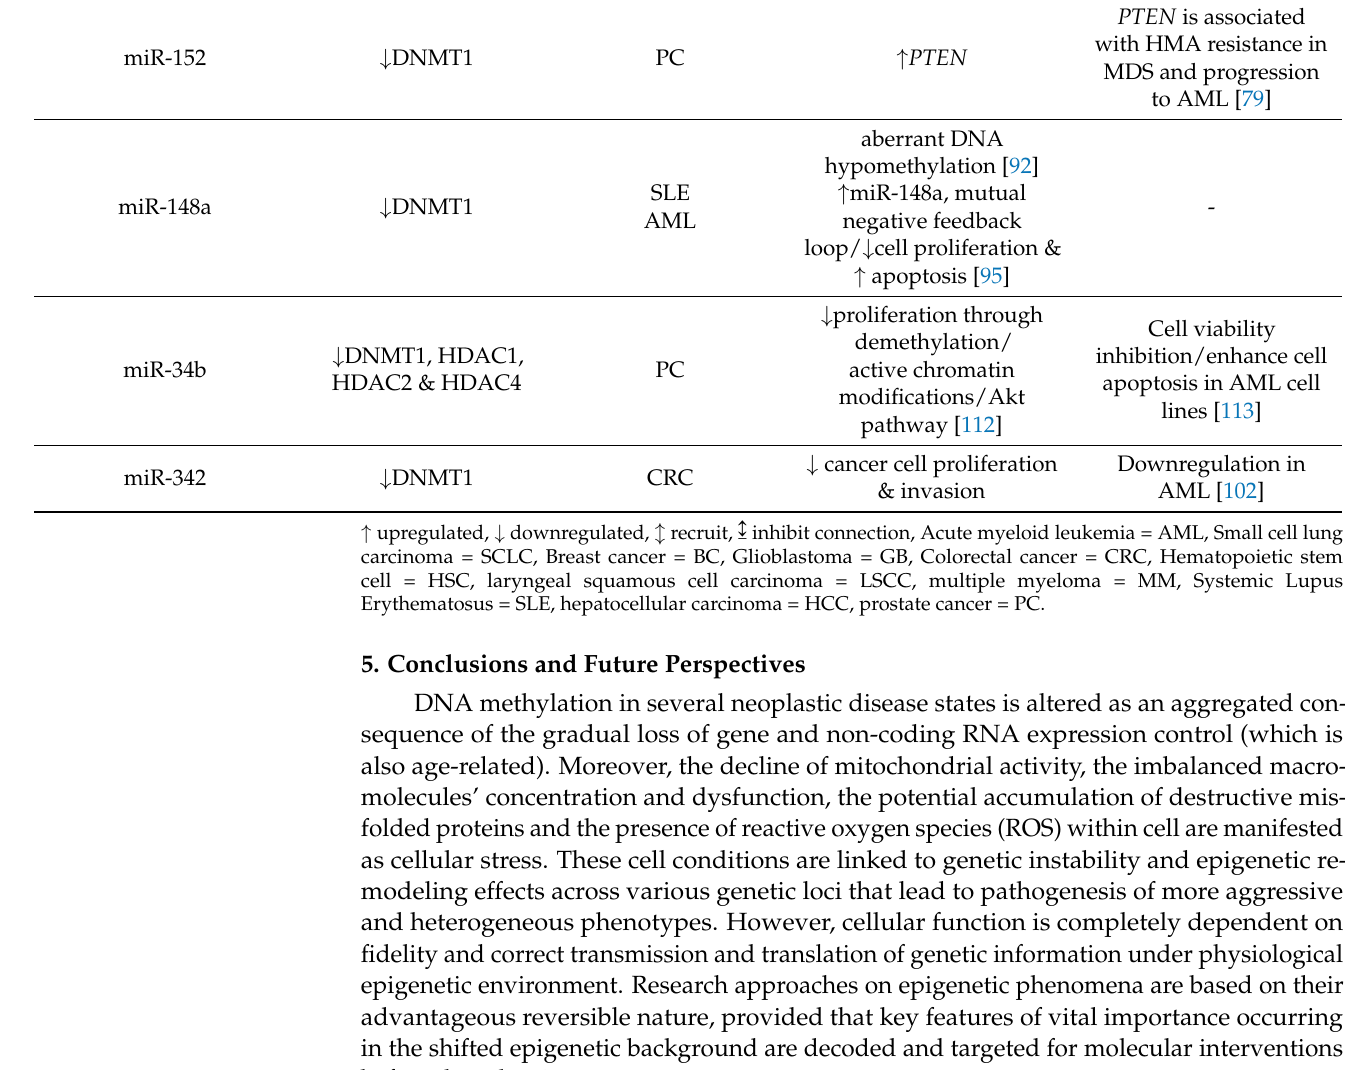
Figure 2. RNAs capable of adopting stem-loop structures exhibit the potential to associate with DNA modifying enzymes depending on RNA secondary structure. The basis of this preferential interaction and targeting of specific CpGs lengthwise genome is the complementarity of DNA-RNA sequences. ( A ). Immature pre-miRNA clusters may bind and provide a scaffold for ei- ther DNMTs or TET enzymes to DNA sites for de novo DNA methylation or demethylation events, respectively. DNA hypermethylation prevents transcription, while even partial demethylation promotes transcription albeit at minimal levels (lower). ( B ). DNA sequences occupied by lncRNAs Table 2. Cont. may prevent enzymatic modifications to DNA by obstructing enzymes from binding, which results in an ongoing transcriptional activity. Table 2. Epigenetic enzymes coregulated by lncRNAs and miRNAs and implicated in MDS and